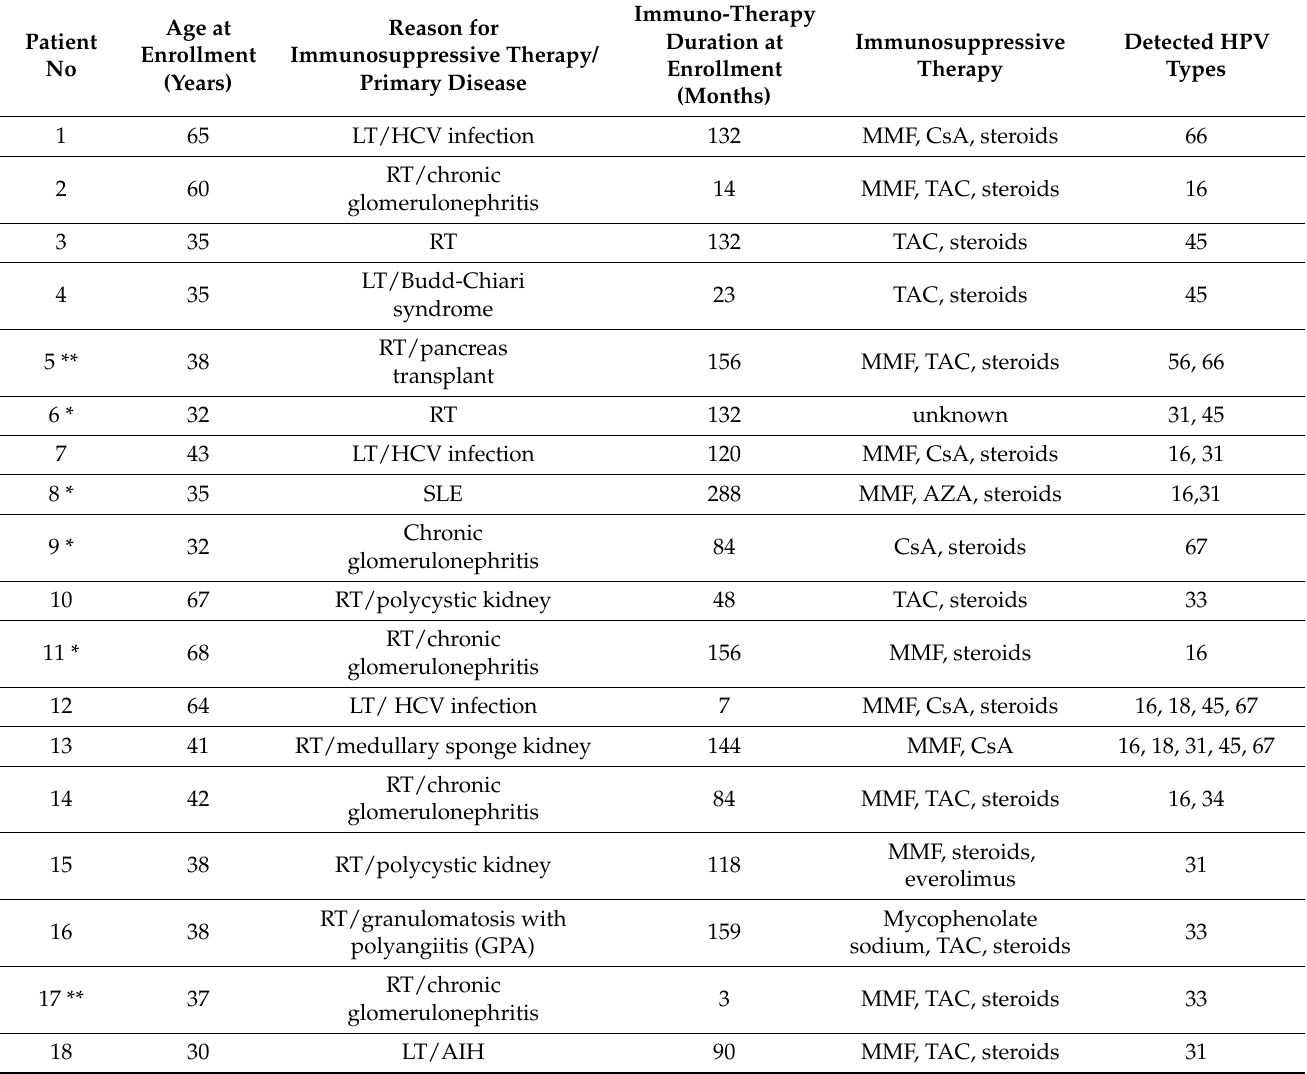
Table 1. Study group’s